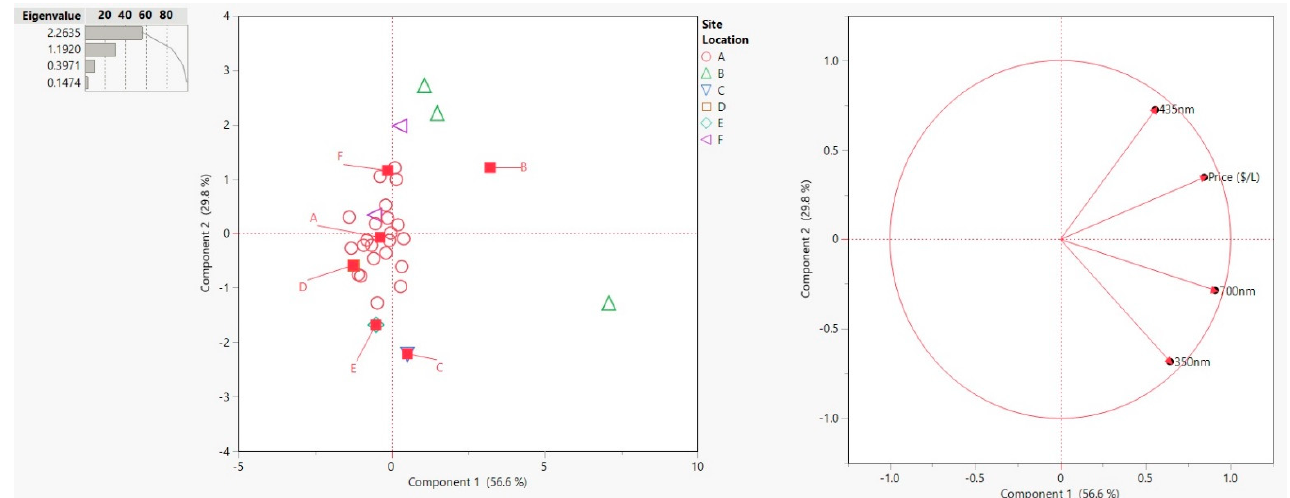
Figure 8. Principal component analysis (PCA) with the score plot on the left side and loading plot on the right side. The plots models 86% of the total data variance. Variance proportions are shown along each component axis.